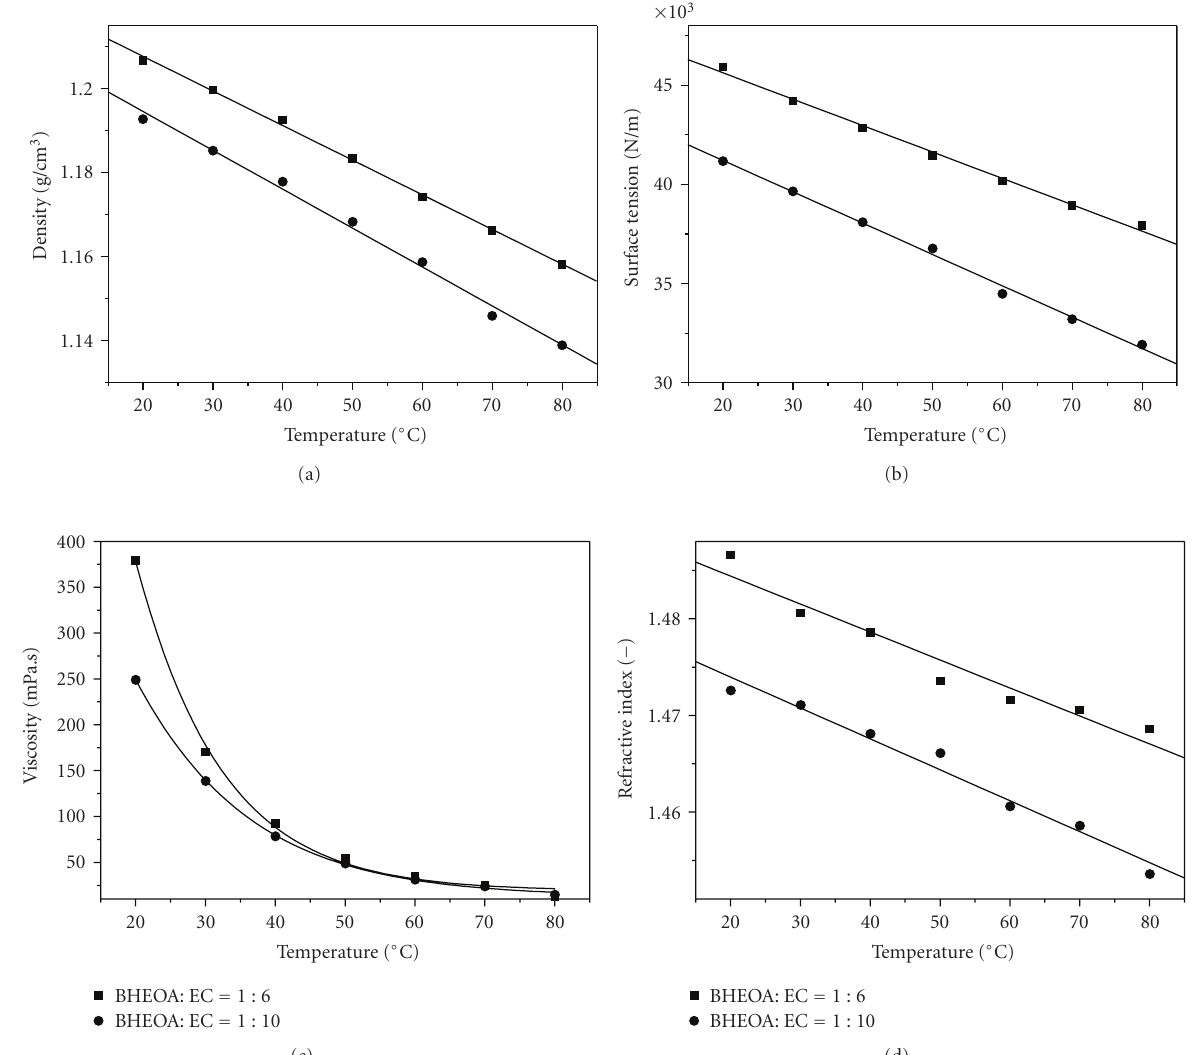
Figure 6: Physical properties of reactions products of BHEOA with EC in function of